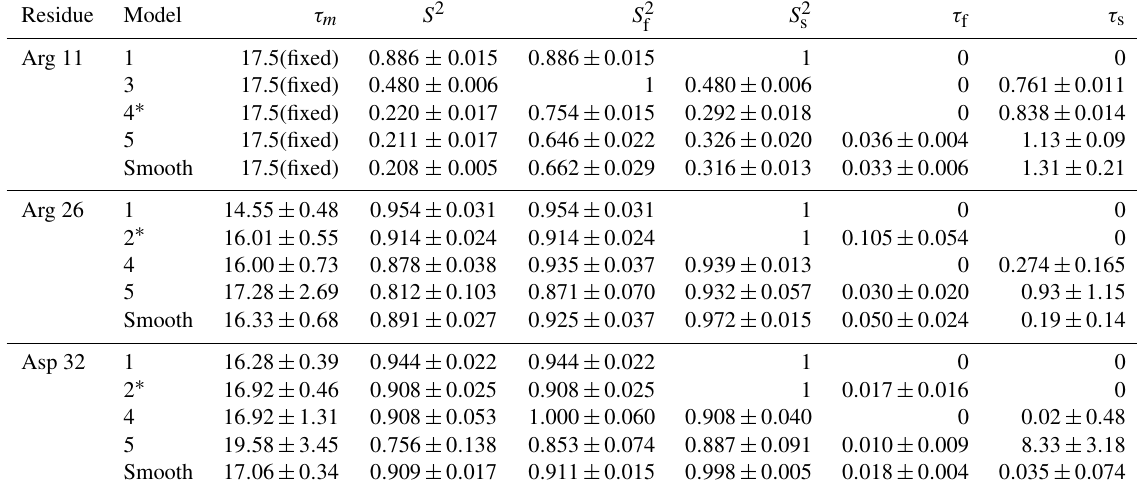
For each residue, parameter values for Models 1–5 are calculated from the fit of the original data to the relevant spectral density function, with errors determined by Monte Carlo simulation. The model selected by AIC C is indicated by ∗ . Smooth values are obtained by averaging the best fit parameter values across bootstrap samples as in Eq. (10), with errors determined as indicated in Eqs.